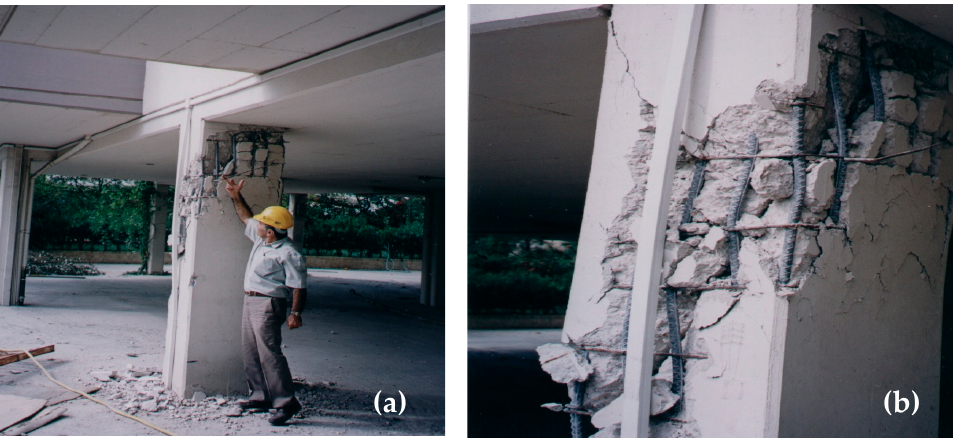
Figure 2. ( a ) Shear failure of an RC column at the ground floor of a four-story RC building. Athens, Greece 1999 earthquake sequence. ( b ) Detail of the same shear damage [1].